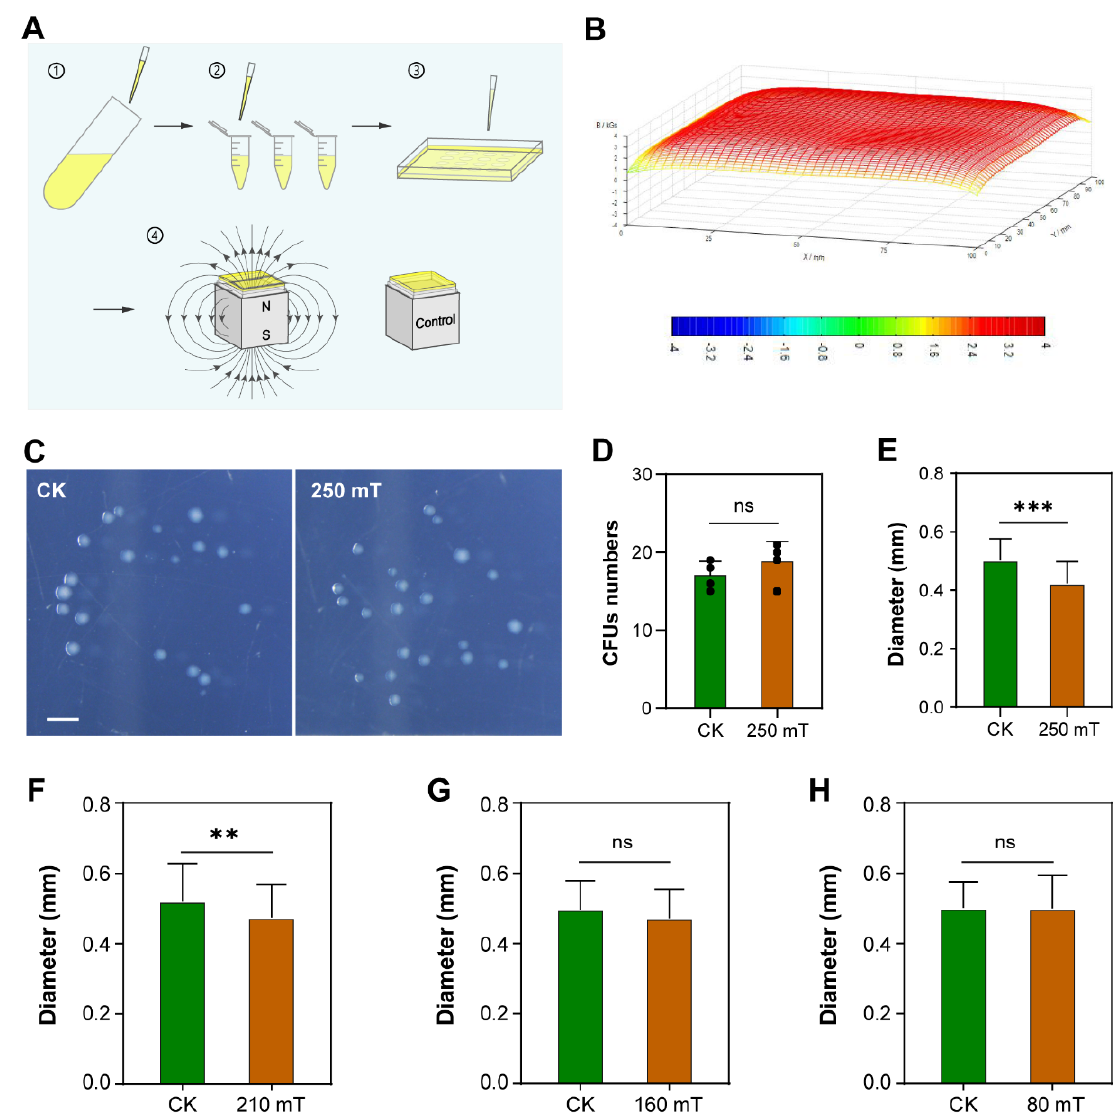
Figure 1. SMF treatment inhibits bacterial growth. ( A ) A diagram to show experimental procedure. Five milliliters bacteria cultured overnight were diluted step by step, and the dilution was spread on the surface of the medium. The petri dish was put on a magnet or a cubic iron as a control at 37 °C. ( B ) Magnetic field distribution of the E. coli growth plane, 10 mm above the NdFeB magnet. ( C ) Phenotype of colonies treated with (250 mT) or without (CK) SMF. ( D ) Effect of SMF on the number of CFUs. ( E – H ) Effect of SMF on the diameter of CFUs. Data shown as mean ± SD. n > 50. Statistical analysis was performed by t -test. ns p > 0.05, ** p < 0.01, *** p < 0.001.